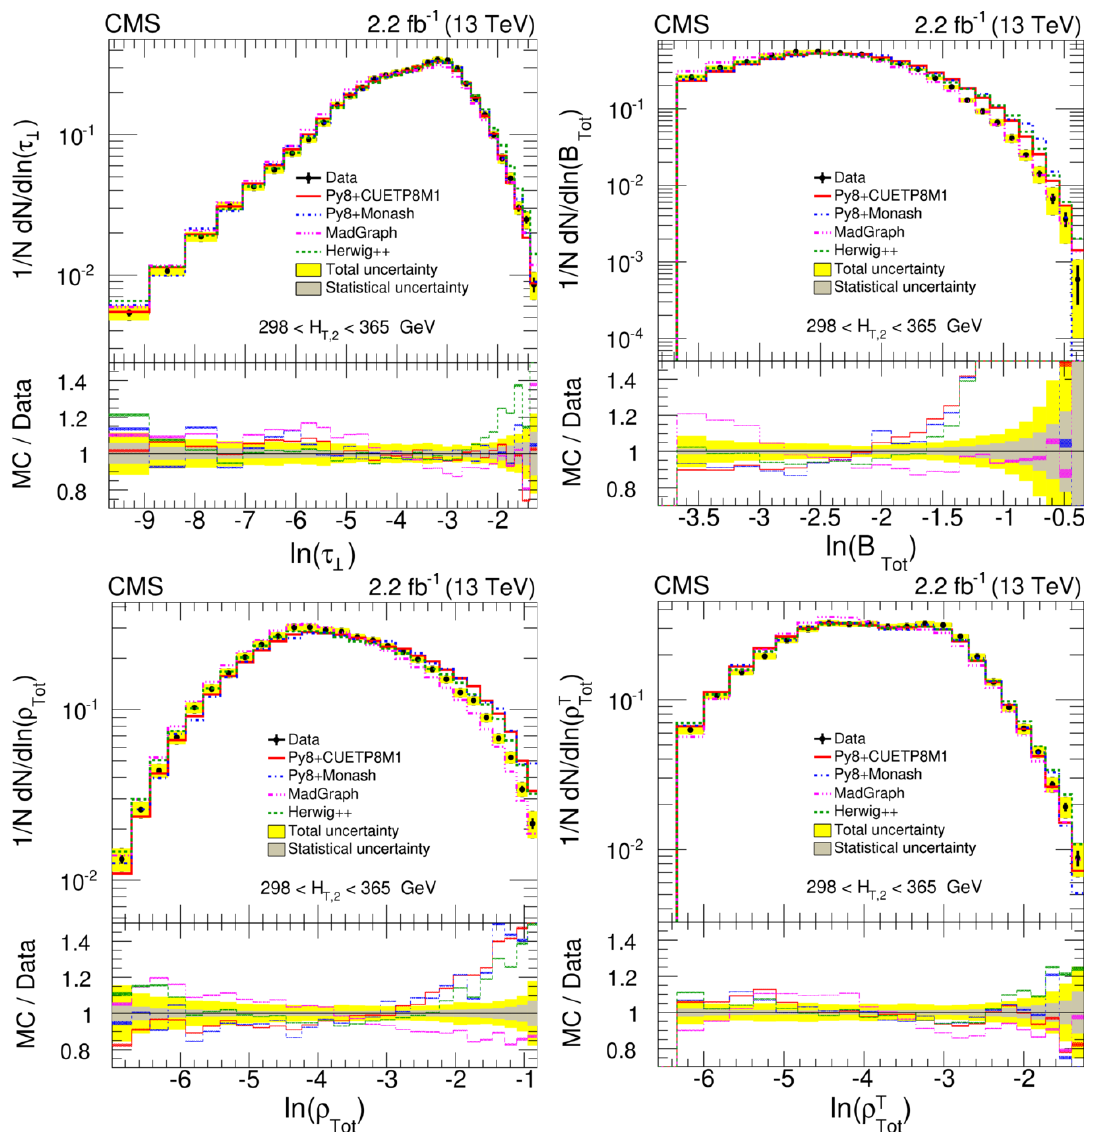
Figure 7 . Normalized di(cid:11)erential distributions of unfolded data compared with theoretical (MC) predictions of pythia 8 CUETP8M1 (red line), pythia 8 Monash (blue dash-dotted line), Mad- Graph 5 a mc@nlo (pink dash-dot-dotted line) and herwig++ (brown dash-dot-dotted line) as a function of ESV: complement of transverse thrust ( (cid:28) ? ) (upper left), total jet broadening ( B Tot ) (upper right), total jet mass ( (cid:26) Tot ) (lower left) and total transverse jet mass ( (cid:26) T 298 < H T ; 2 < 365 GeV. In each ratio plot, the inner gray band represents statistical uncertainty and the yellow band represents the total uncertainty (systematic and statistical components added in quadrature) on data and the MC predictions include only statistical uncertainty.